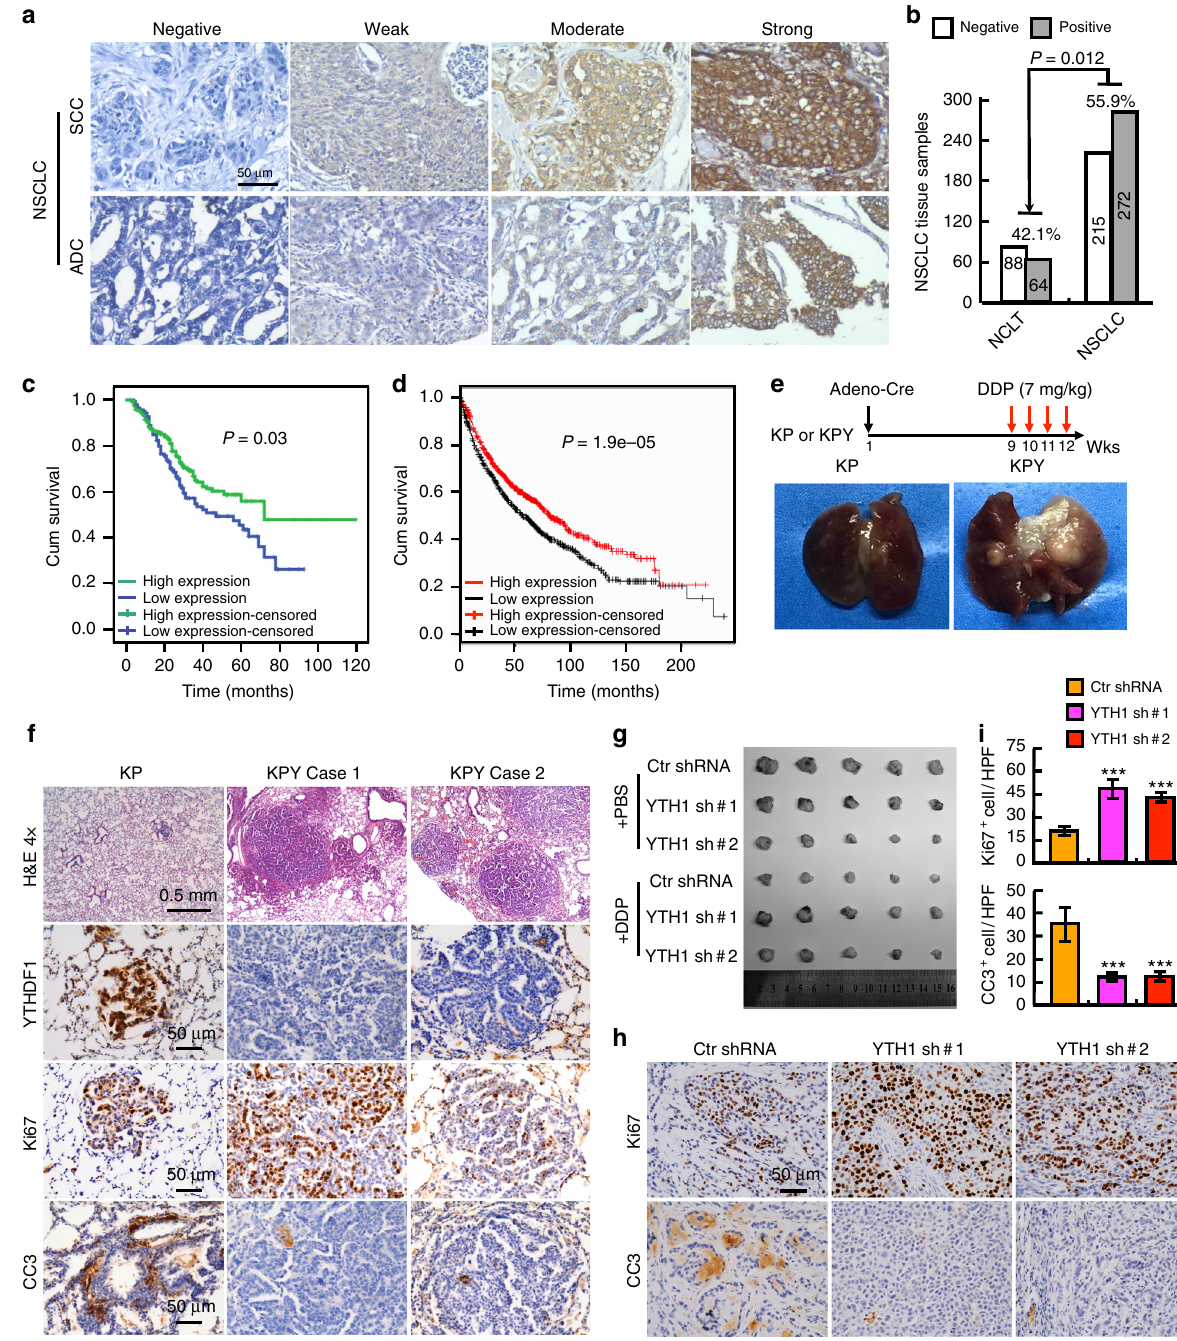
Fig. 4 YTHDF1 high expression correlates with a better clinical outcome. a IHC staining, ×200. The negative, weak, moderate and strong expression of YTHDF1 protein expression patterns in lung squamous cell carcinoma (SCC) or lung adenocarcinoma (ADC). b Quanti fi cation data for IHC ( a ). c , d YTHDF1 high expression in NSCLC correlates with better clinical outcome, data generated from IHC staining ( c ) and network database ( d ). e Schematic diagram shows the experimental strategy for cisplatin (DDP) treatment in KP and KPY mice. Representative lung tissues after DDP treatment are shown. f Representative H&E and immunostaining for tumors collected from KP and KPY mice after DDP treatment. Scale bars are indicated for each image. Antibodies are: YTHDF1, Ki67, CC3. g Xenograft tumor masses harvested from indicated mice treated by indicated conditions. DDP: 7 mg per kg, once a week for 3 weeks. h , i Representative IHC staining for indicated xenograft tumors after DDP treatment. Scale bar: 50 μ m. Antibodies are: Ki67 and CC3. ( i ) is the quanti fi cation data for ( h ). Means ± SEM, * P < 0.05; ** P < 0.01; *** P < 0.001; t -test transcription factor playing a key role in endogenous antioxidant ECH-associated protein 1) functions as a negative regulator for processes, which regulates the expression of antioxidant genes Nrf2, which is deactivated under oxidative stress condition 47 . To explore the underlying mechanism, we reanalyzed our mass-spec including aldo-keto reductases 1C1 and 1C2, (AKR1C1 and data and noticed that Keap1 and Nrf2 were inversely regulated AKR1C2), heme oxygenase 1 (HO-1) and NADP(H), under both upon YTHDF1 knockdown, as shown by decreased Keap1 but physiological and oxidative stress conditions 46 . Keap1 (Kelch-like NATURE COMMUNICATIONS| (2019) 10:4892